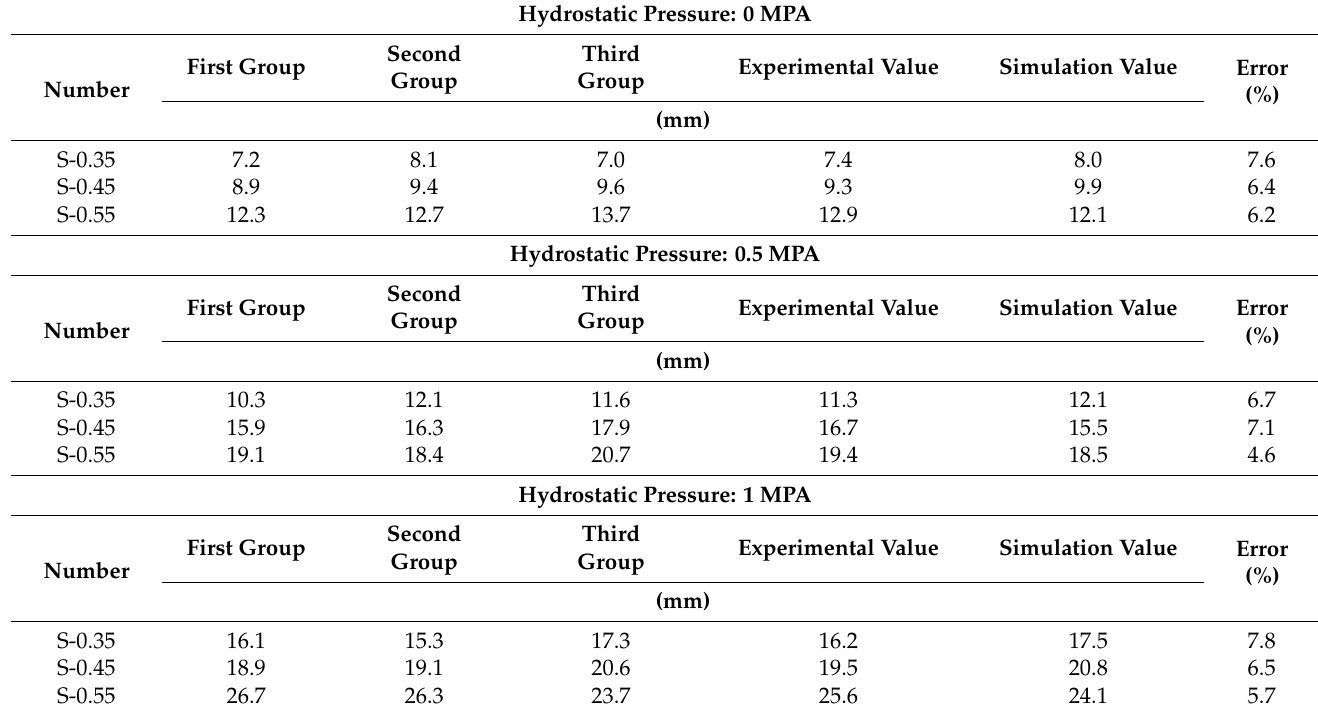
Table 8. Test and simulation results for the cement mortar.